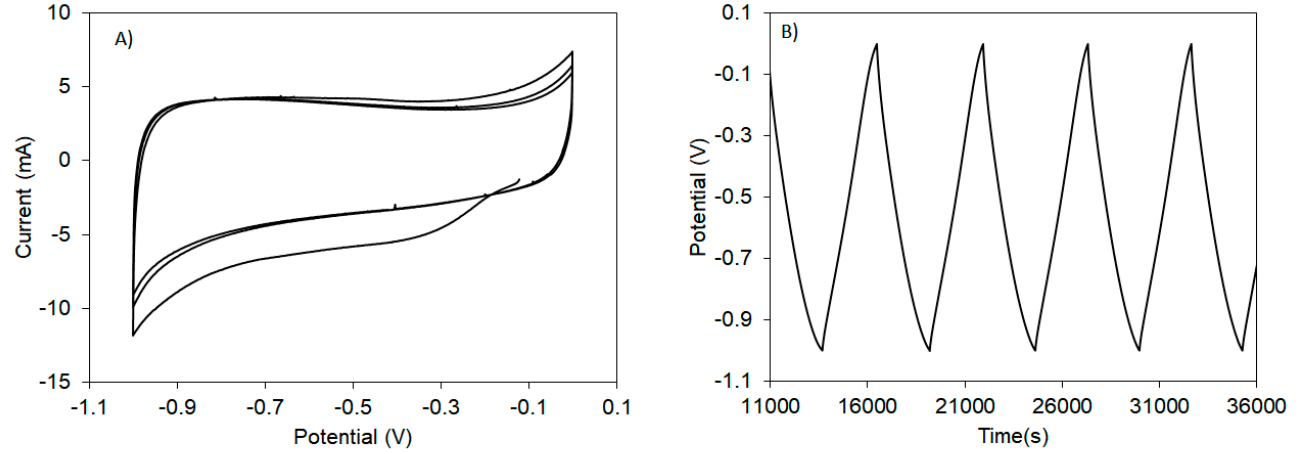
Figure 11. ( A ) CV of AC-600-800 in 6 M KOH electrolyte, scan rate: 1 mV s − 1 . ( B ) Galvanostatic charge-discharge curves using AC-600-800 in 6 M KOH with specific current of 0.15 A g − 1 .